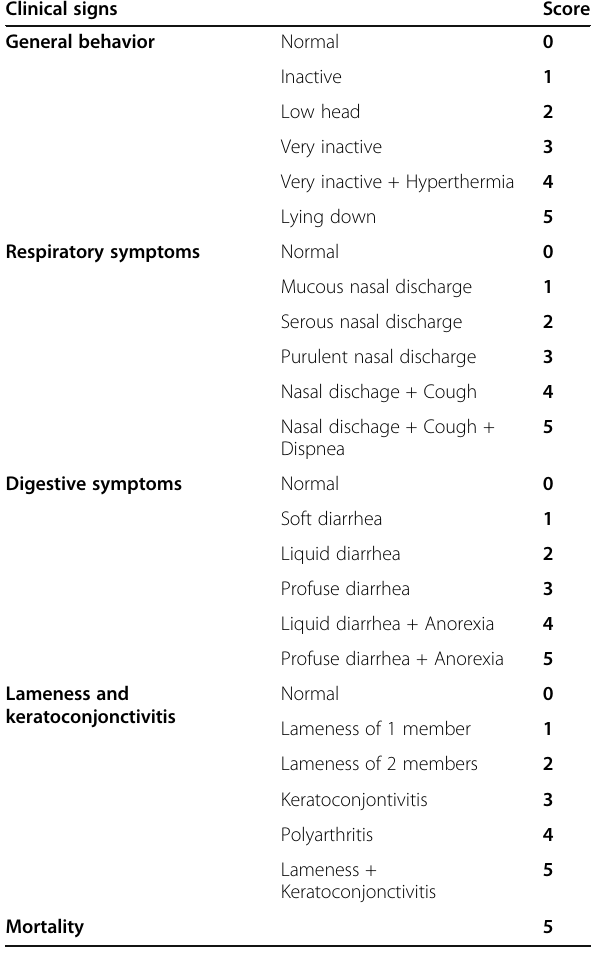
Table 4 Scoring of recorded clinical signs Clinical